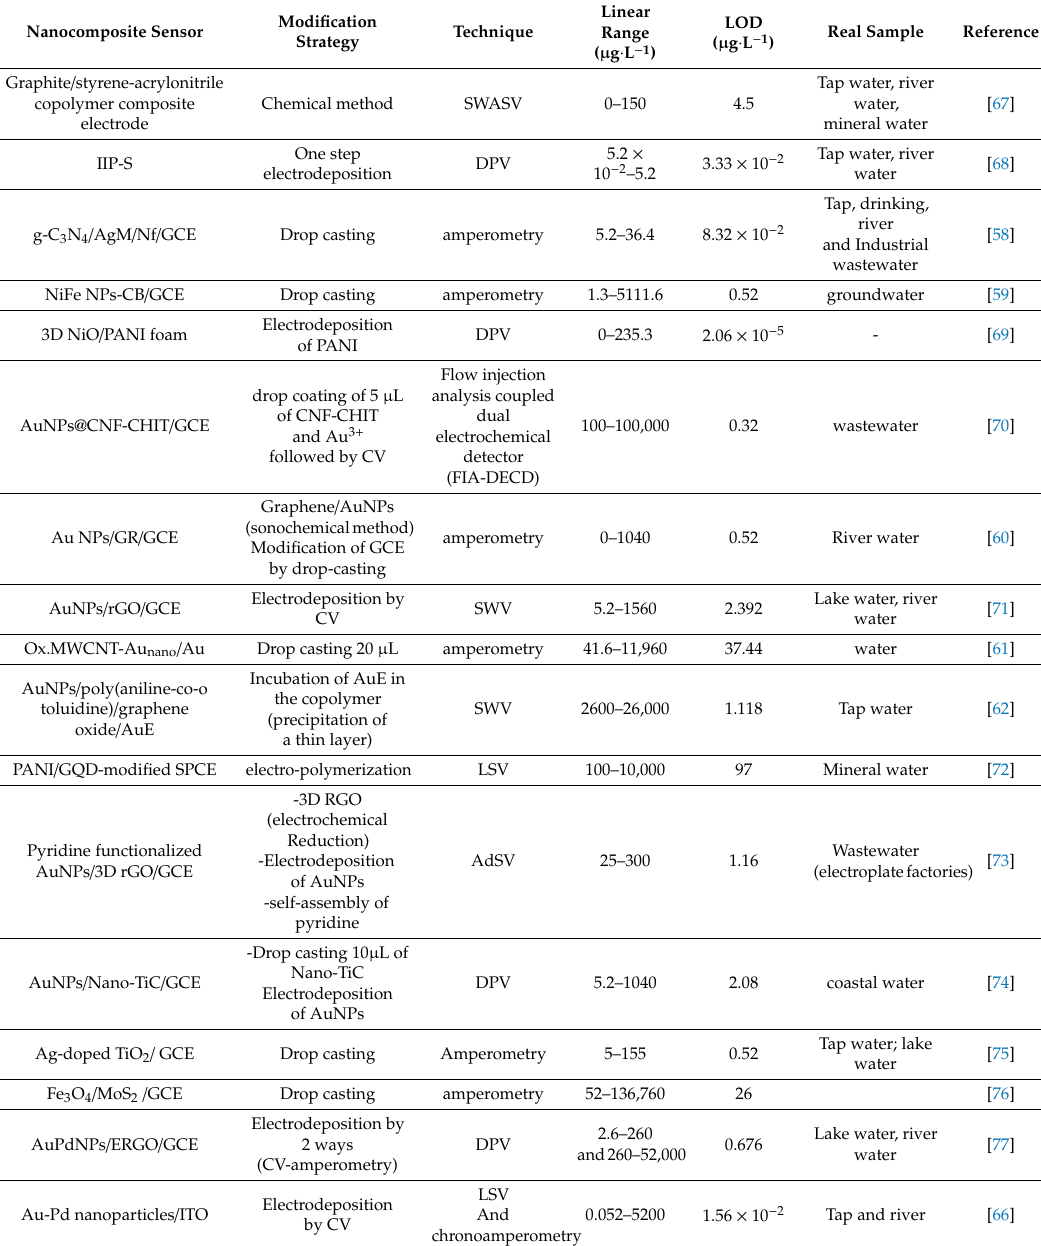
Table 3. Summary of the electroanalytical data of reported nanocomposite-based electrodes for hexavalent chromium